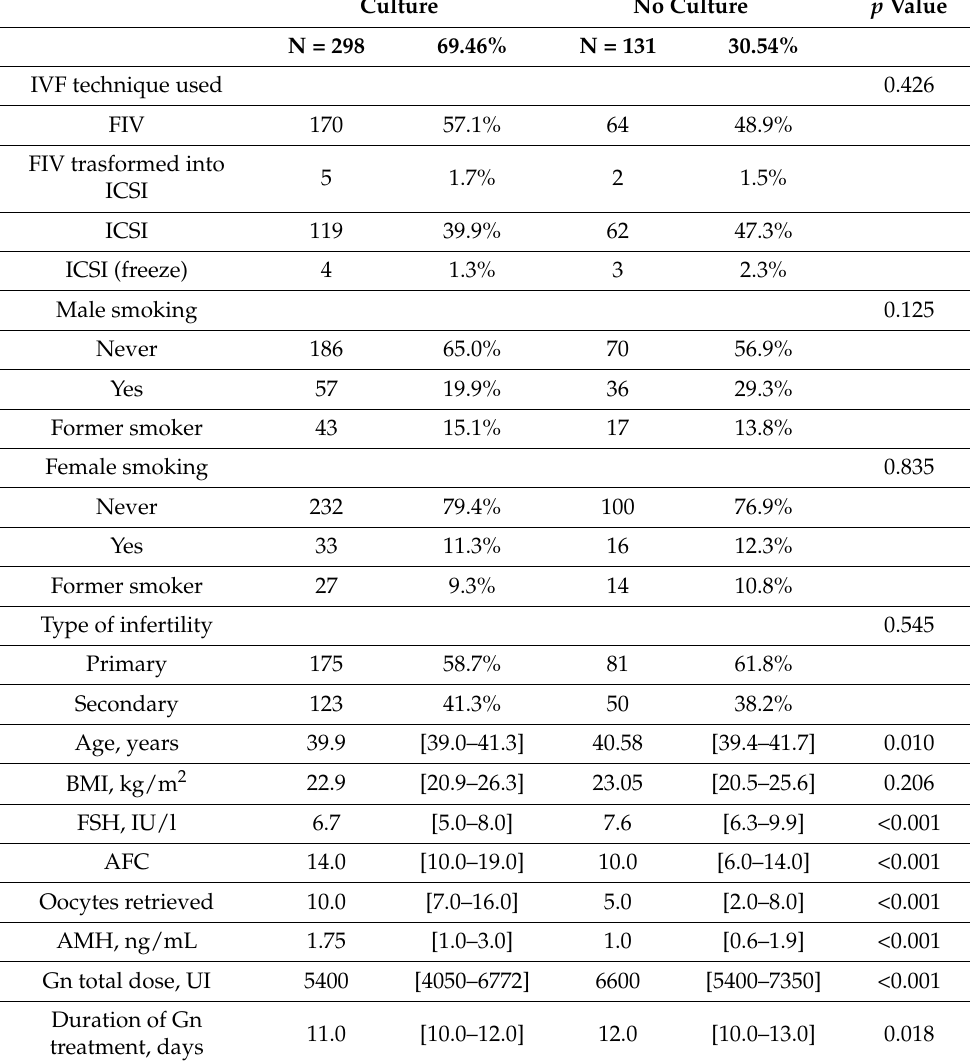
Table 1. Characteristics of the study population. Culture: group of patients who obtained a successful embryo culture. No culture: group of patients who did not obtain a successful embryo culture. N and percentage for categorical variables and median and median + (25th percentile–75th